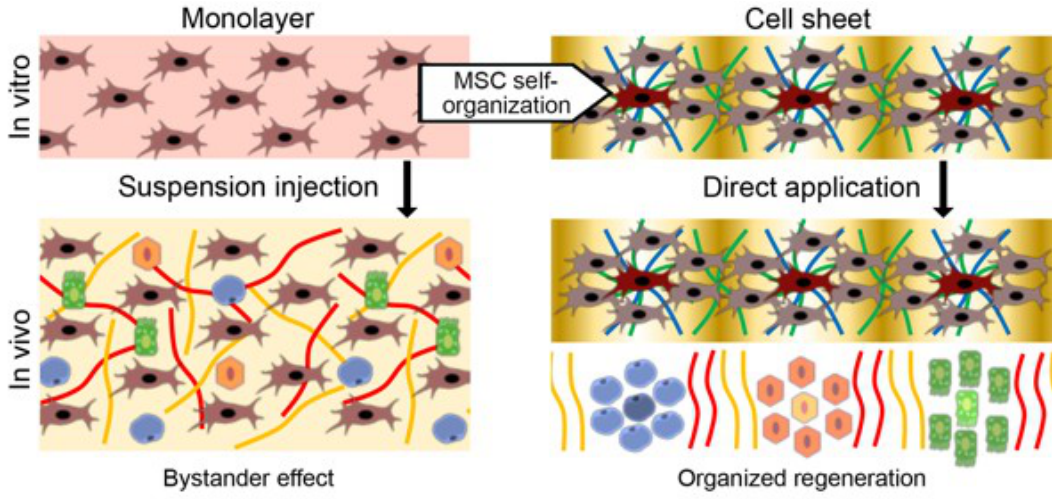
Figure 3. Self-organization of MSCs as a basis of their organizing function in regeneration. Conventionally used injection of MSCs cultured in monolayer (left part) is limited to paracrine (bystander) effects of delivered cells. Self-organization during CS formation results in retention of the microenvironment with the formation of stimuli gradients that organize regeneration after delivery (right part).